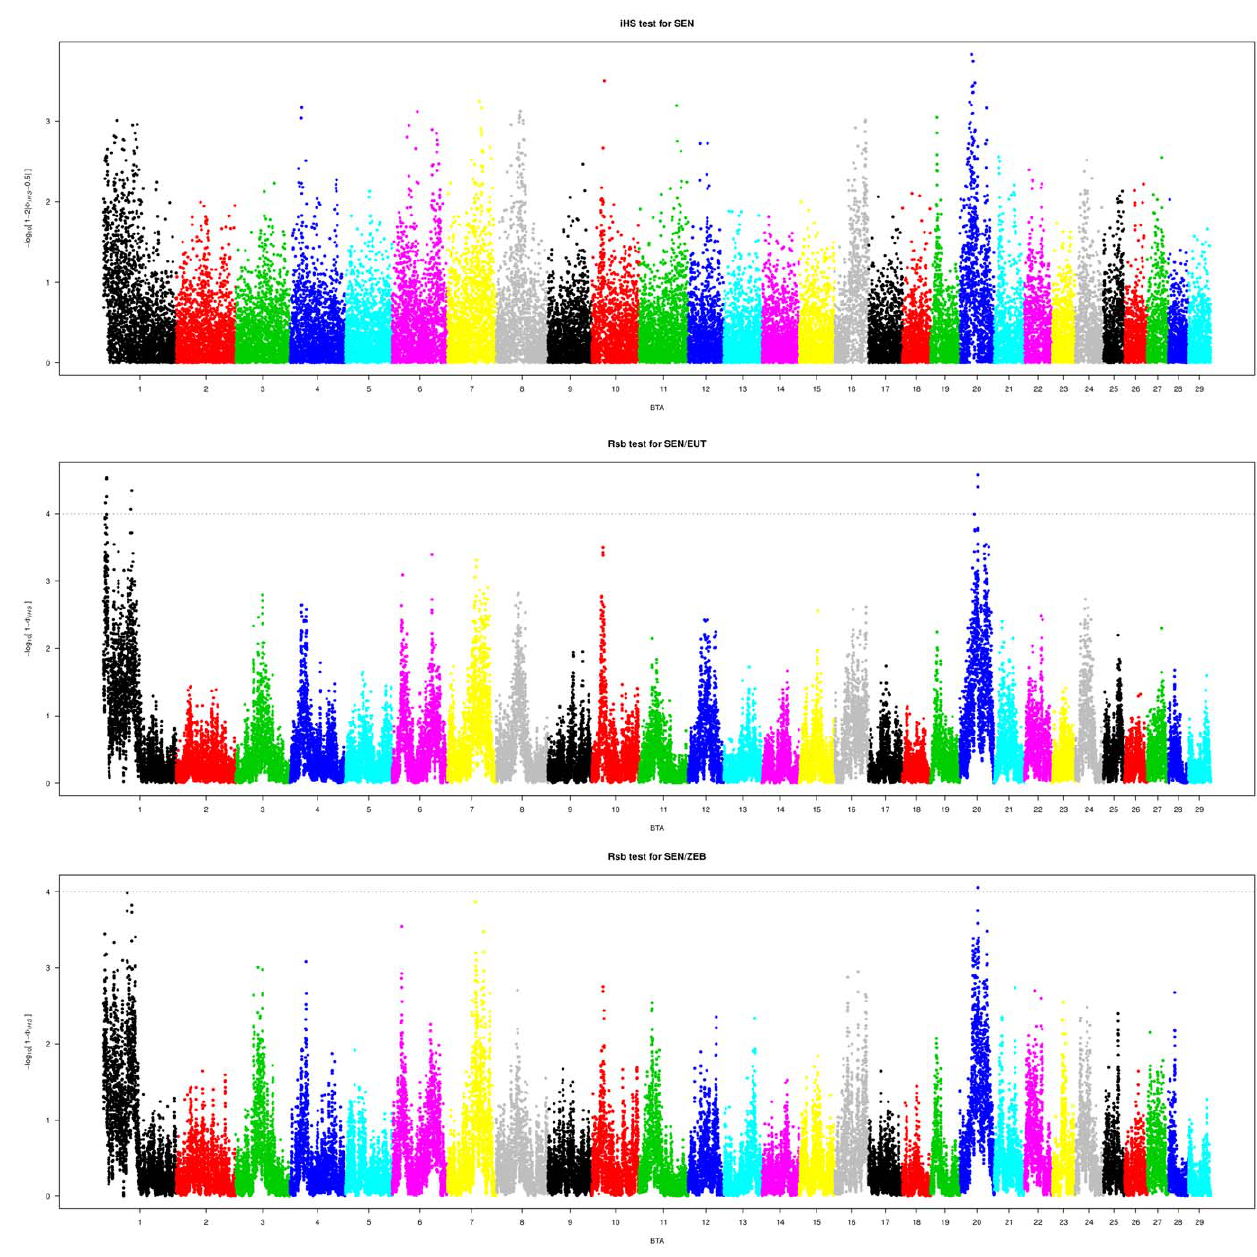
Figure 2. Plots over the genome of the SEN iHS (a) and ZEB/SEN (b) and EUT/CGU (c) Rsb scores for each SNP.